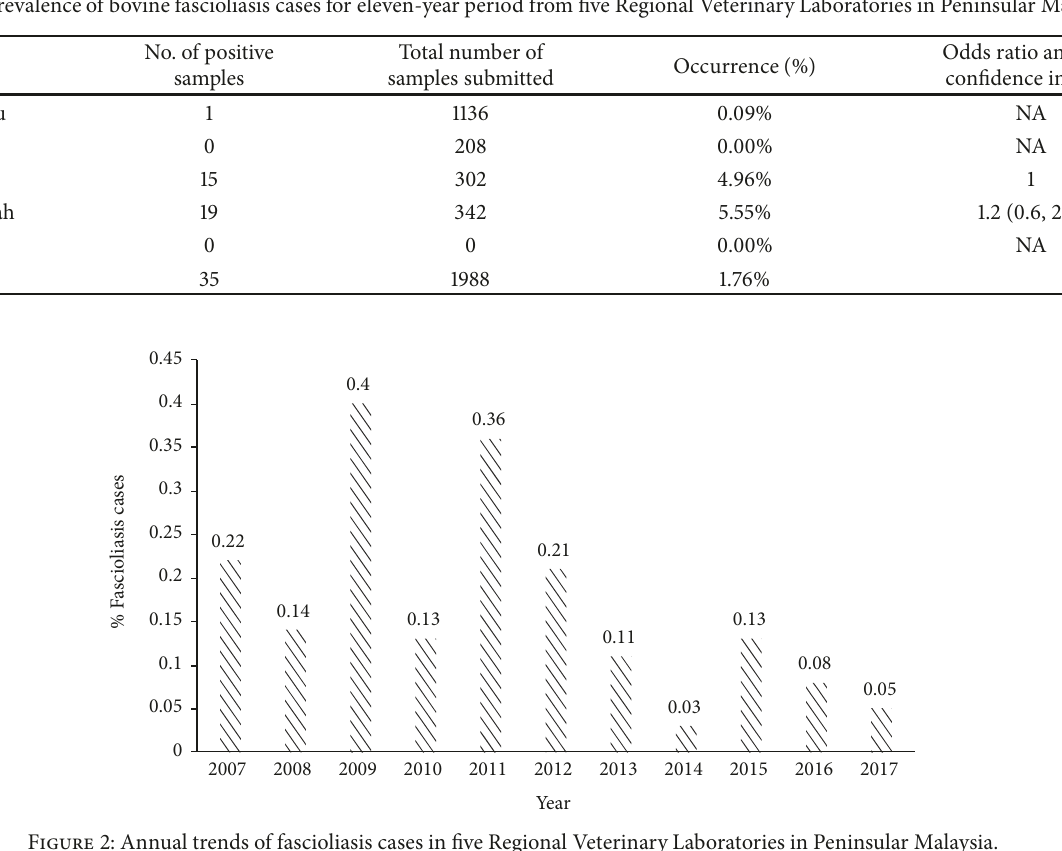
Figure 2: Annual trends of fascioliasis cases in five Regional Veterinary Laboratories in Peninsular Malaysia.